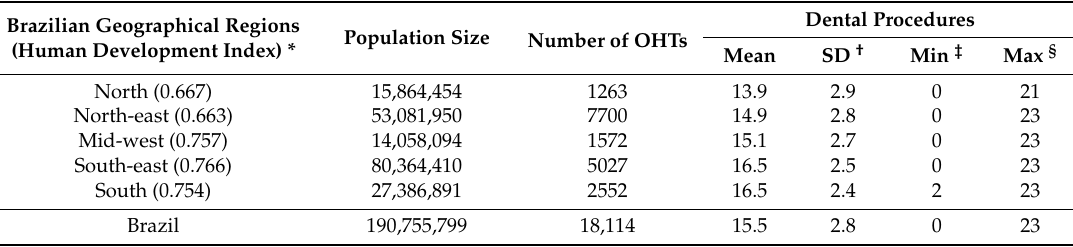
Table 2. Average number of dental procedures performed by oral health teams in Brazilian geographical regions,